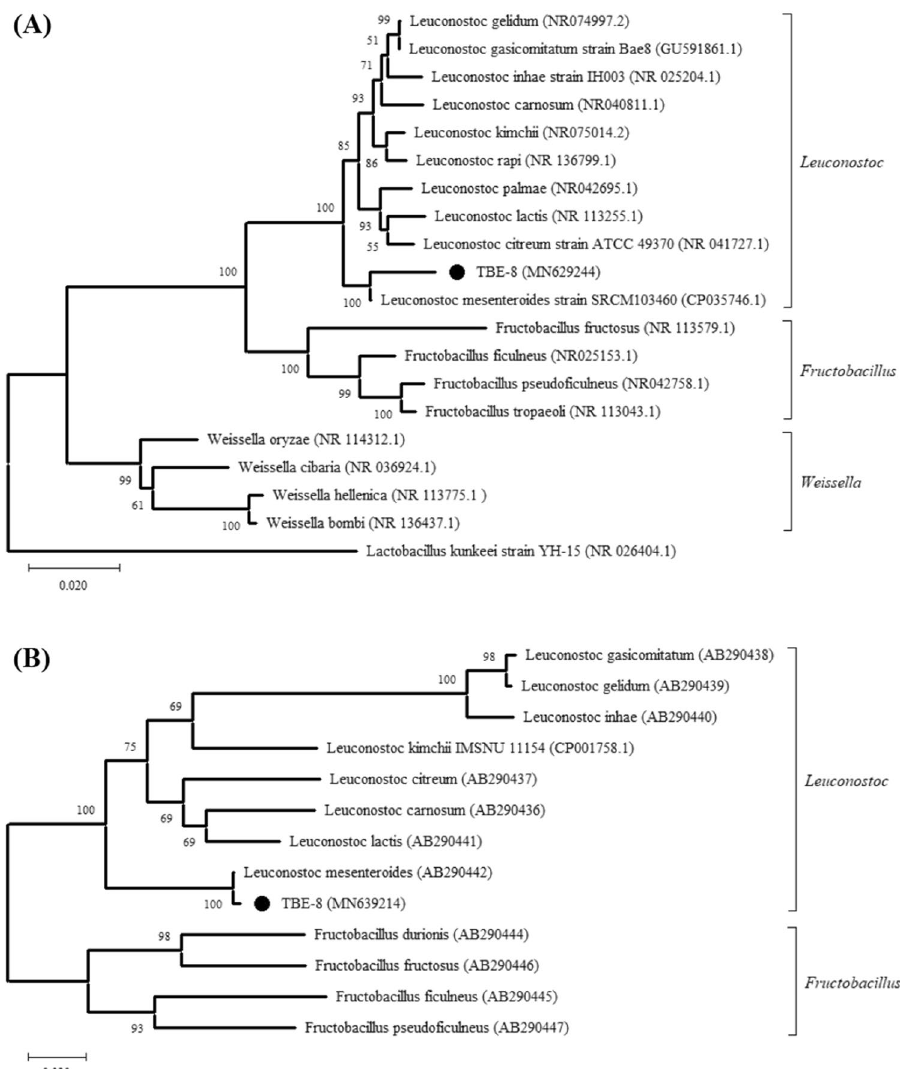
Figure 1. Phylogenetic tree of the isolate lactic acid bacterium TBE-8 constructed using the sequences of 16S rDNA ( A ) and the 16S–23S rDNA intergenic spacer region (ISR) ( B ). The isolated TBE-8 strain is labeled as a black spot. Sequences for the 16S rDNA phylogenetic analysis were obtained from the GenBank database for the following strains: Leuconostoc gelidum , Leuconostoc gasicomitatum , Leuconostoc inhae , Leuconostoc carnosum , Leuconostoc kimchii , Leuconostoc rapi , Leuconostoc palmae, Leuconostoc lactis , Leuconostoc citreum , Leuconostoc mesenteroides , Fructobacillus fructosus , Fructobacillus ficulneus , Fructobacillus pseudoficulneus ,